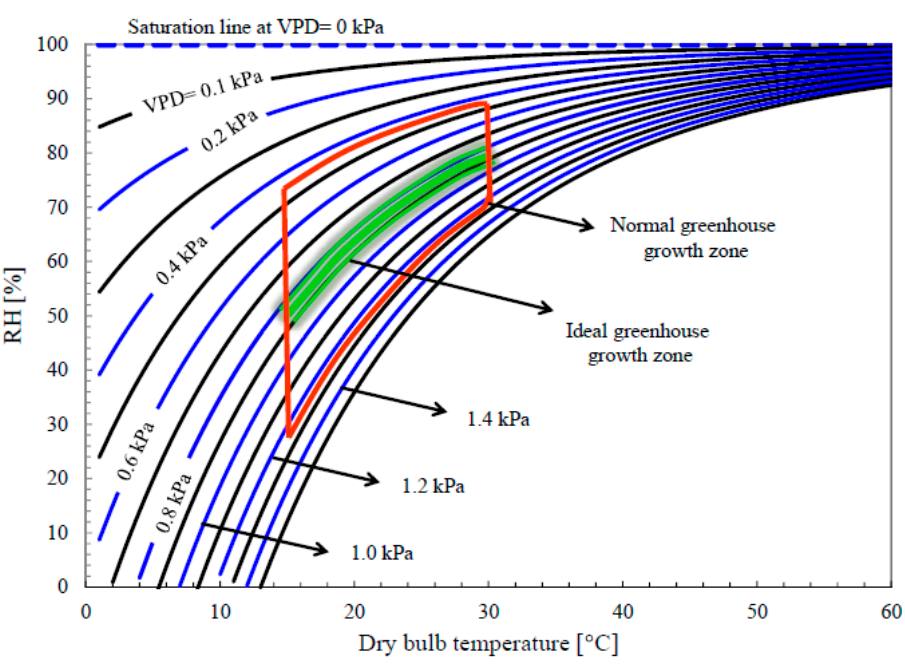
Figure 1. Normal and ideal greenhouse growth zones according to vapor pressure deficit levels [13]. Reprinted with permission from Ref. [13]. Copyright 2016